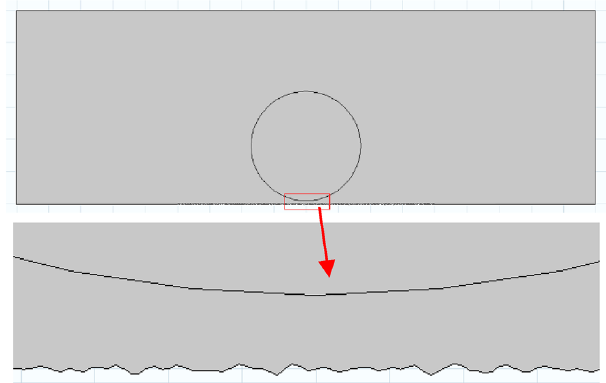
Figure 5. Geometric model of the